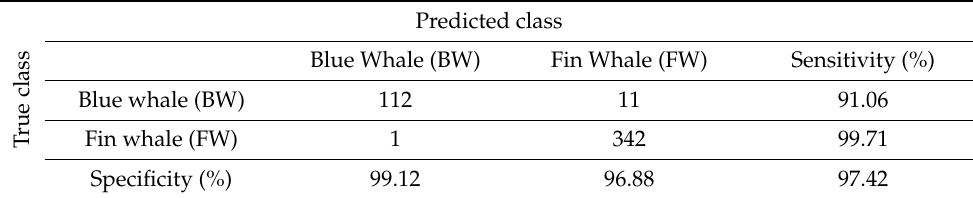
Table 4. The confusion matrix for the proposed method with the ‘Blue whale (BW) + Fin whale (FW)’ dataset (the accuracy (%) is indicated in bold font and calculated as a ratio of the sum of diagonal values to the sum of all values ×